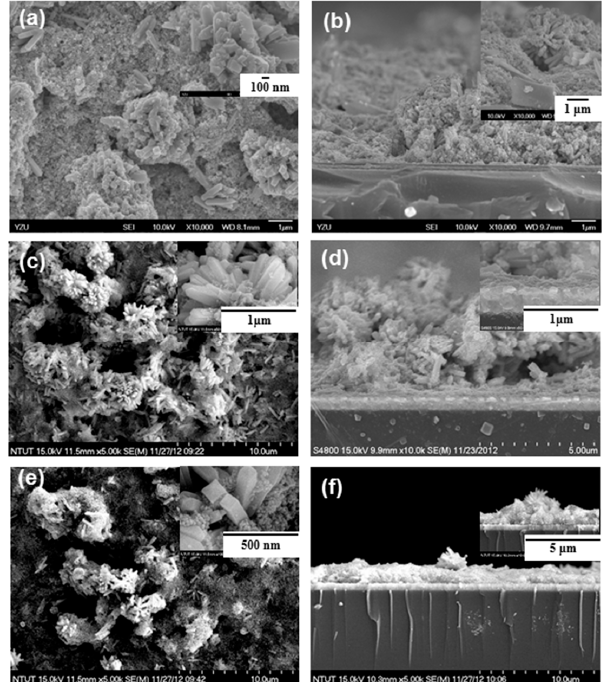
Figure 1. Scanning electron microscope (SEM) micrographs of ( a ) SnO 2 nanocomposite (SNC) (1:1); ( c ) SNC (1:0.5); and ( e ) SNC (0.5:1) top views; and ( b ), ( d ), and ( f ) cross ‐ sectional views. The inset micrographs are corresponding high magnification views.